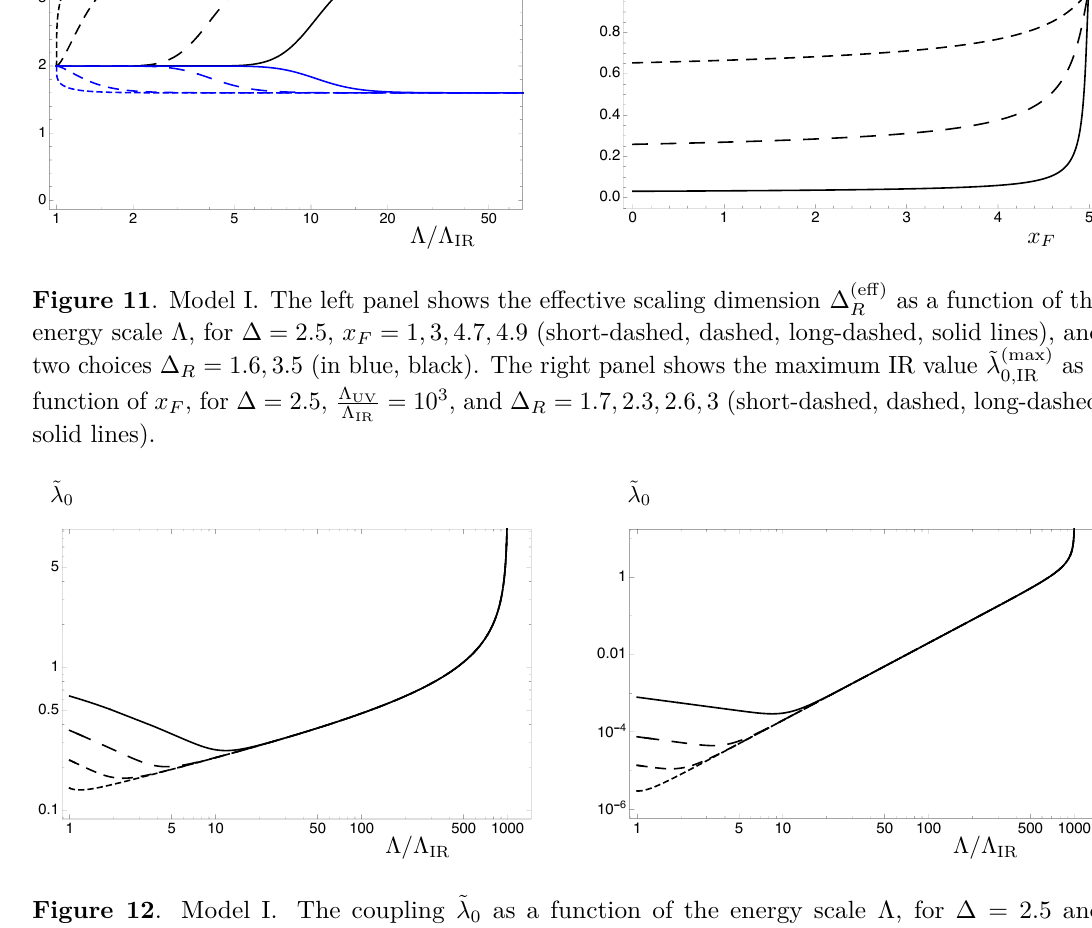
Figure 12 . Model I. The coupling ˜ λ 0 as a function of the energy scale Λ , for ∆ = 2 . 5 and x F = 2 , 4 . 2 , 4 . 7 , 4 . 9 (short-dashed, dashed, long-dashed, solid lines), and ∆ R = 2 . 75 , 4 . 5 (left, right panels). For each of the flows depicted, the parameter ˜ λ 0 , IR is chosen such that the Landau pole is at Λ UV = 10 3 Λ IR